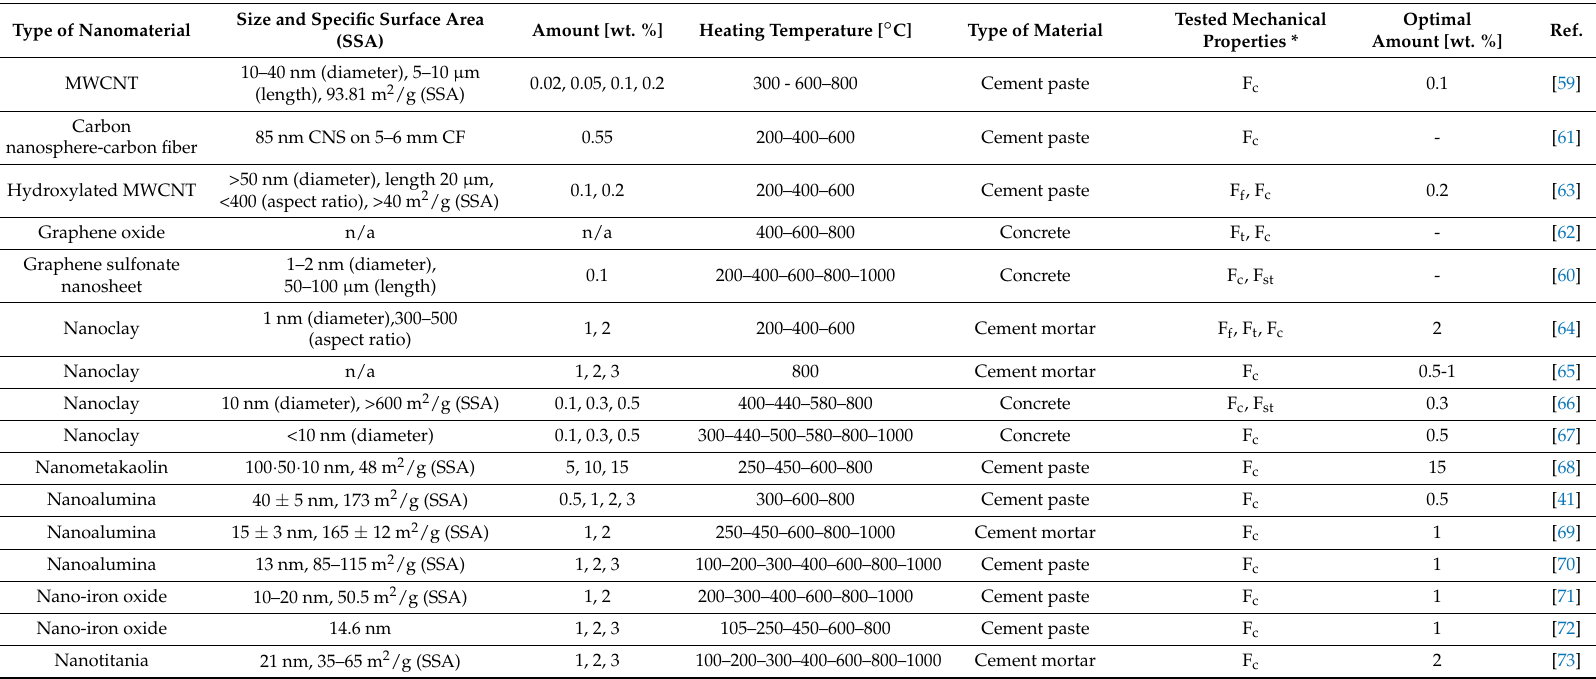
Table 3. Summary of available studies related to the effect of various nanomaterials on thermal resistance of cement-based